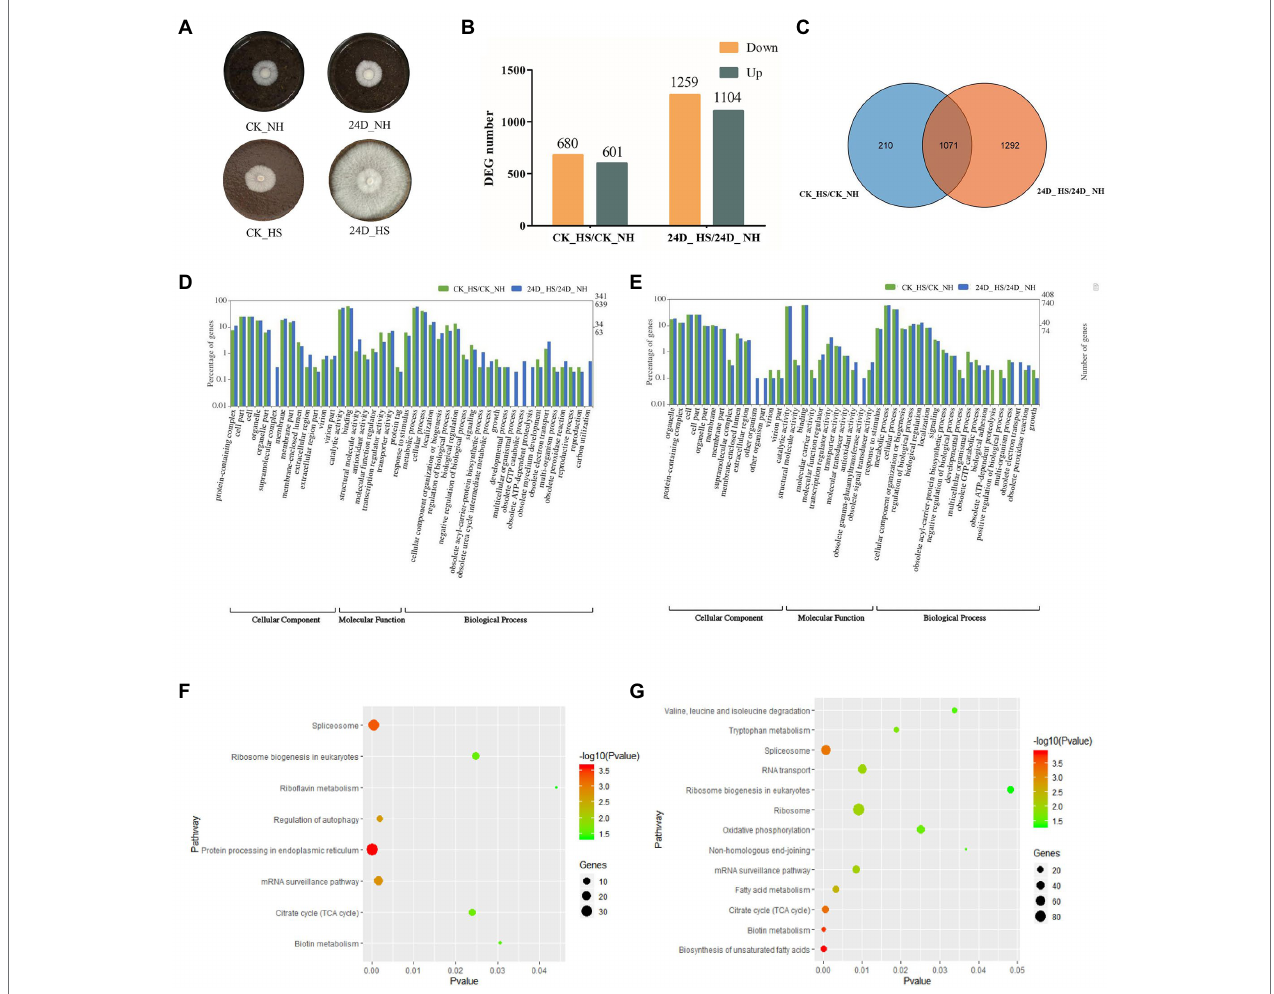
FIGURE 1 | RNA-seq data analysis results of CK_HS/CK_NH and 24D_ HS/24D_ NH. (A) L. edodes mycelium cultured at 25 ° C for 6 days on sawdust medium, shown as CK_NH and 24D_ NH, followed by heat stress at 40 ° C for 24 h, and culture at 25 ° C for 15 days to resume growth, shown as CK_HS and 24D_ HS. (B) Column diagram for the number of DEGs. (C) Venn diagram for the number of DEGs. (D) GO term analysis results of up-regulated DEGs in CK_HS/CK_NH and 24D_ HS/24D_ NH. (E) GO term analysis results of down-regulated DEGs in CK_HS/CK_NH and 24D_ HS/24D_ NH. (F) KEGG pathway analysis results for CK_ HS/CK_NH DEGs. (G) KEGG pathway analysis results for 24D_ HS/24D_ NH DEGs. CK_NH: no heat stress; CK_HS: heat stress; 24D_NH: exogenous 2,4-D without heat stress; 24D_HS: exogenous 2,4-D with heat stress. DEGs, differentially expressed